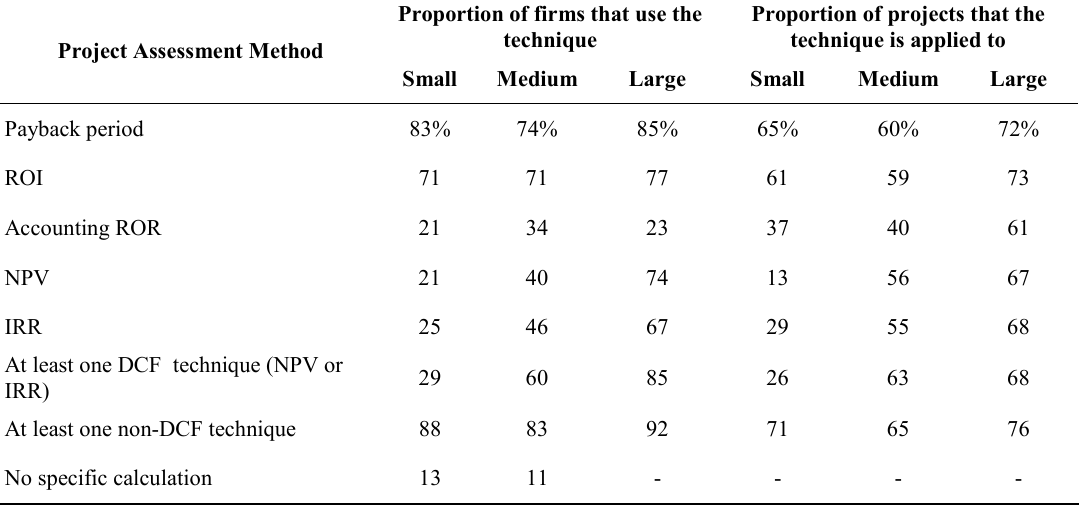
Table 3. Use of capital expenditure evaluation techniques by firm size Proportion of firms that use